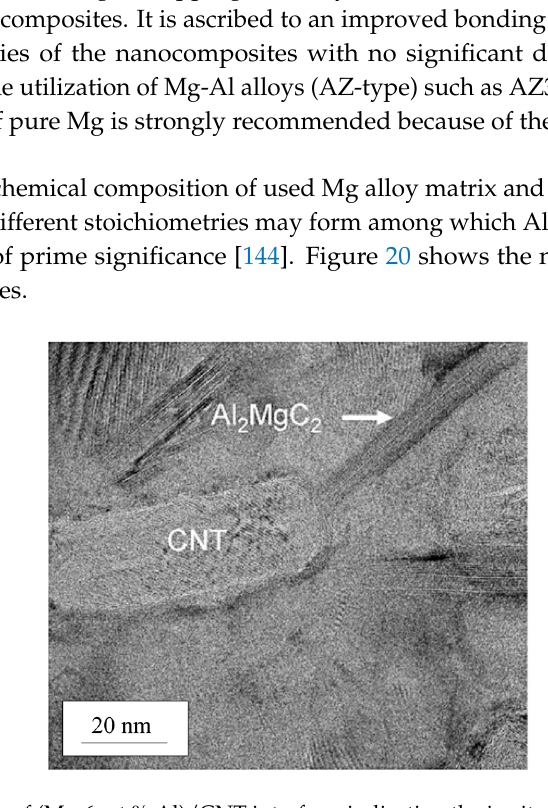
Figure 19. SEM image of fracture surface of CNT-Ti nanocomposites in different magnifications [140]: ( a ) ×5000; ( b ) ×65,000. (Adapted with permission from [140], Elsevier, 2009.)